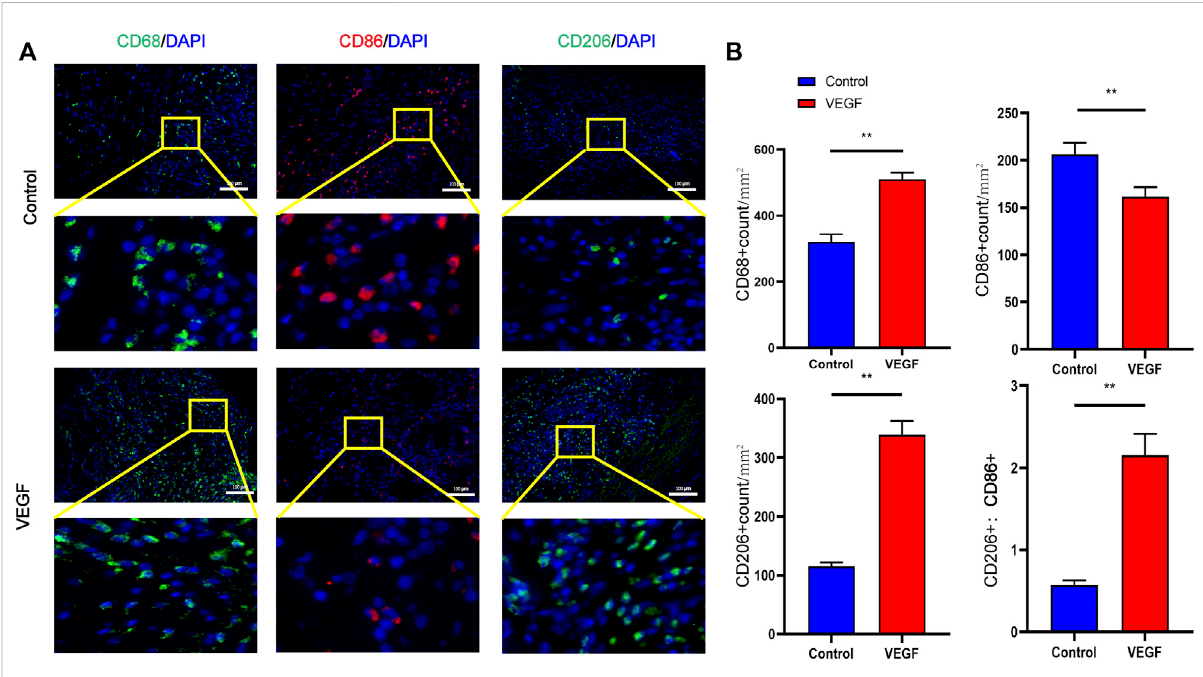
FIGURE 9 Representative immuno fl uorescence images of vascular grafts at day 28 in each group (A) . CD68 and CD206 stained in green, CD86 stained in red. Quanti fi cation of CD68 + total macrophages, CD86 + M1-macrophages, CD206+ M2-macrophages and M2/M1 (CD206+/CD86 + ) ratio (B) . * p < 0.05. ** p < 0.01. ns represents no signi fi cant difference.